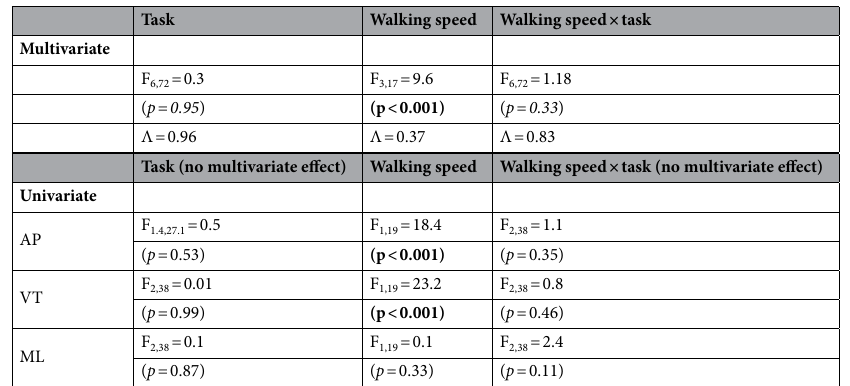
Table 1. Multivariate and univariate analysis results following a 2 × 3 RMANOVA assessing the influence of walking speed instruction and task on the root-mean-square ratio (RMSratio). ‘Λ’ denotes Wilk’s lambda; ‘F’ denotes the F-statistic (extent of the difference between group means). ‘ p ’ denotes the statistical significance; the threshold for significance was set at p < 0.05. ML mediolateral measurement axis, VT vertical measurement axis, AP anteroposterior measurement